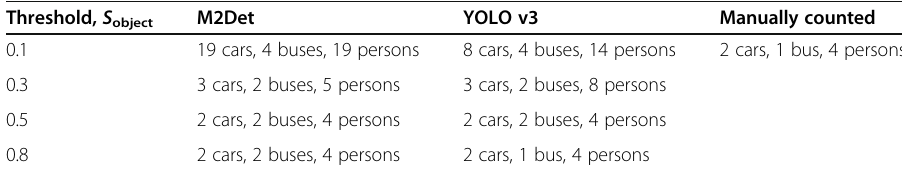
Table 2 Maximum number of recognized objects ( “ car, ” “ bus (truck), ” and “ person ” ) Threshold, S object M2Det YOLO v3 Manually counted